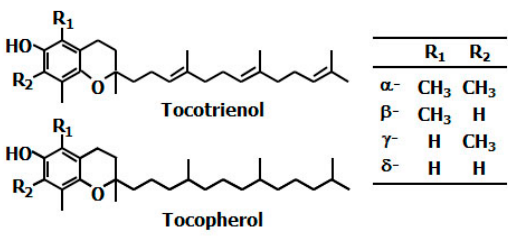
Figure 1. Chemical structure of vitamin E.